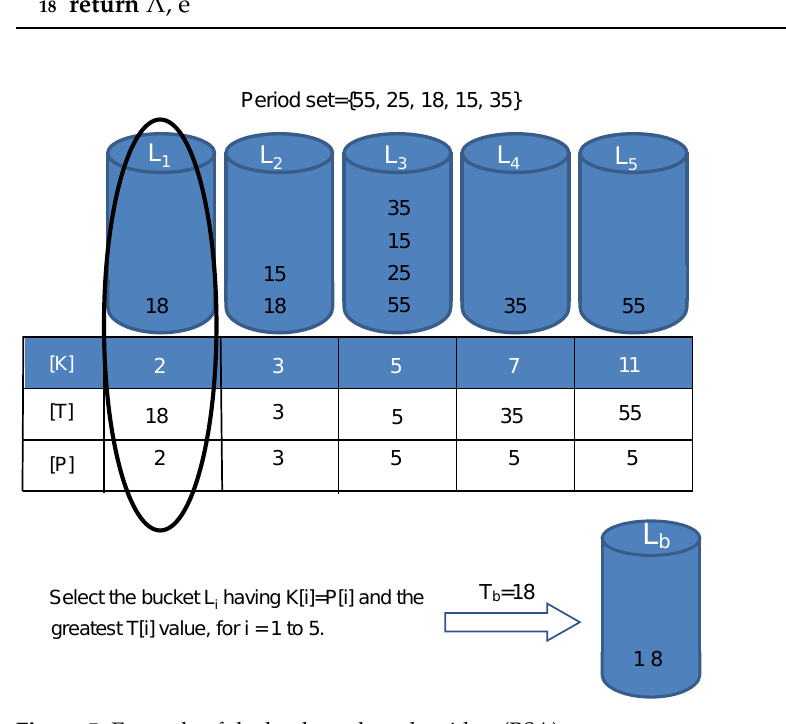
Figure 5. Example of the bucket select algorithm